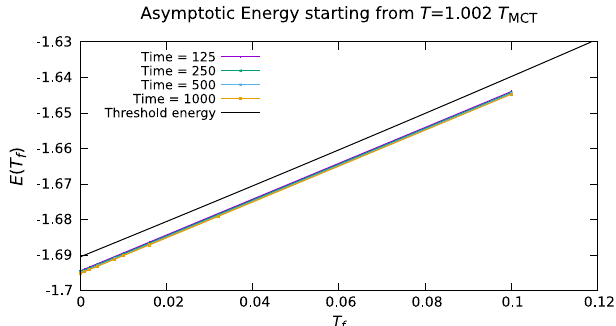
FIG. 7. The dependence of the dynamical energy of the ( 3 þ 4 )- spin model as a function of the temperature T f . Data measured at different times are smooth and linear in T f and clearly below the threshold energy (shown by the upper line). At small enough T f , such an energy difference cannot be compensated by an entropy increase, as discussed in the